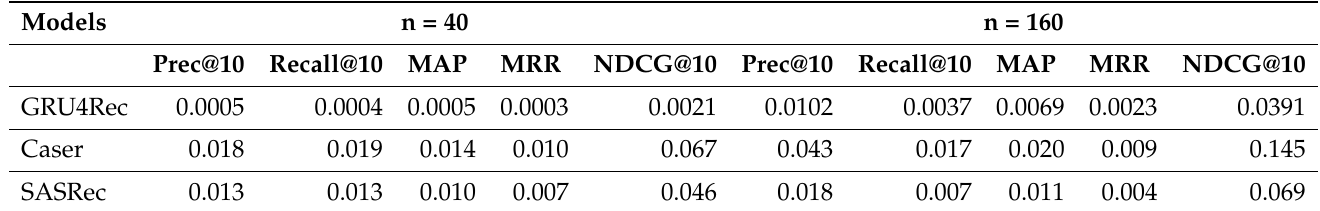
Table 4. Recommendation performance comparison of different models on GitHub dataset.